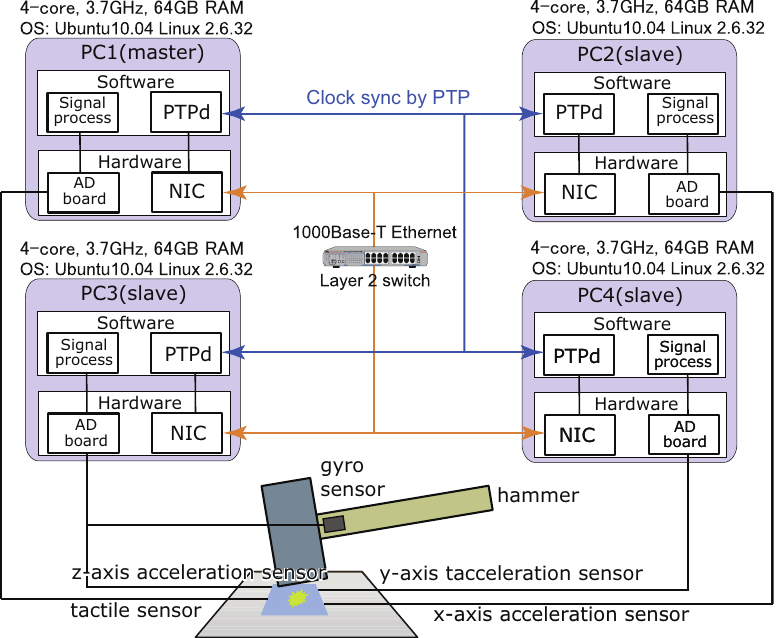
Figure 7. Experimental set-up using various sensors. Adapted from